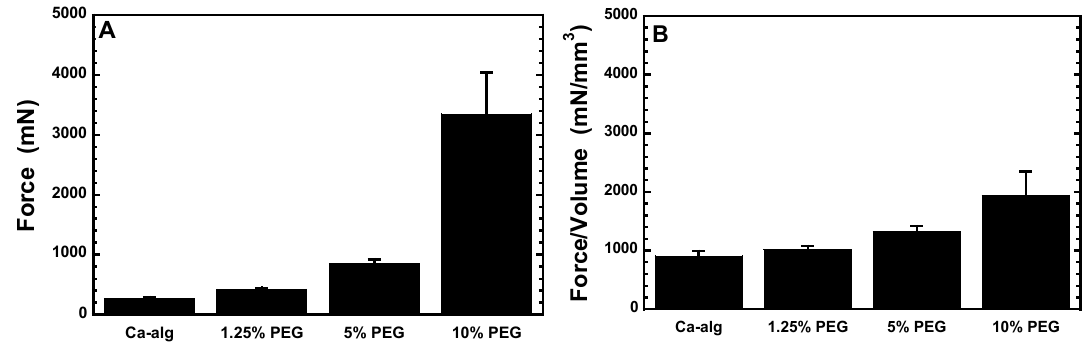
Figure 3. Mechanical resistance to compression up to 90% of the microsphere diameter of individual alg-PEG-M prepared with 0%–10% ( w / v ) PEG-VS ( n = 30 ±